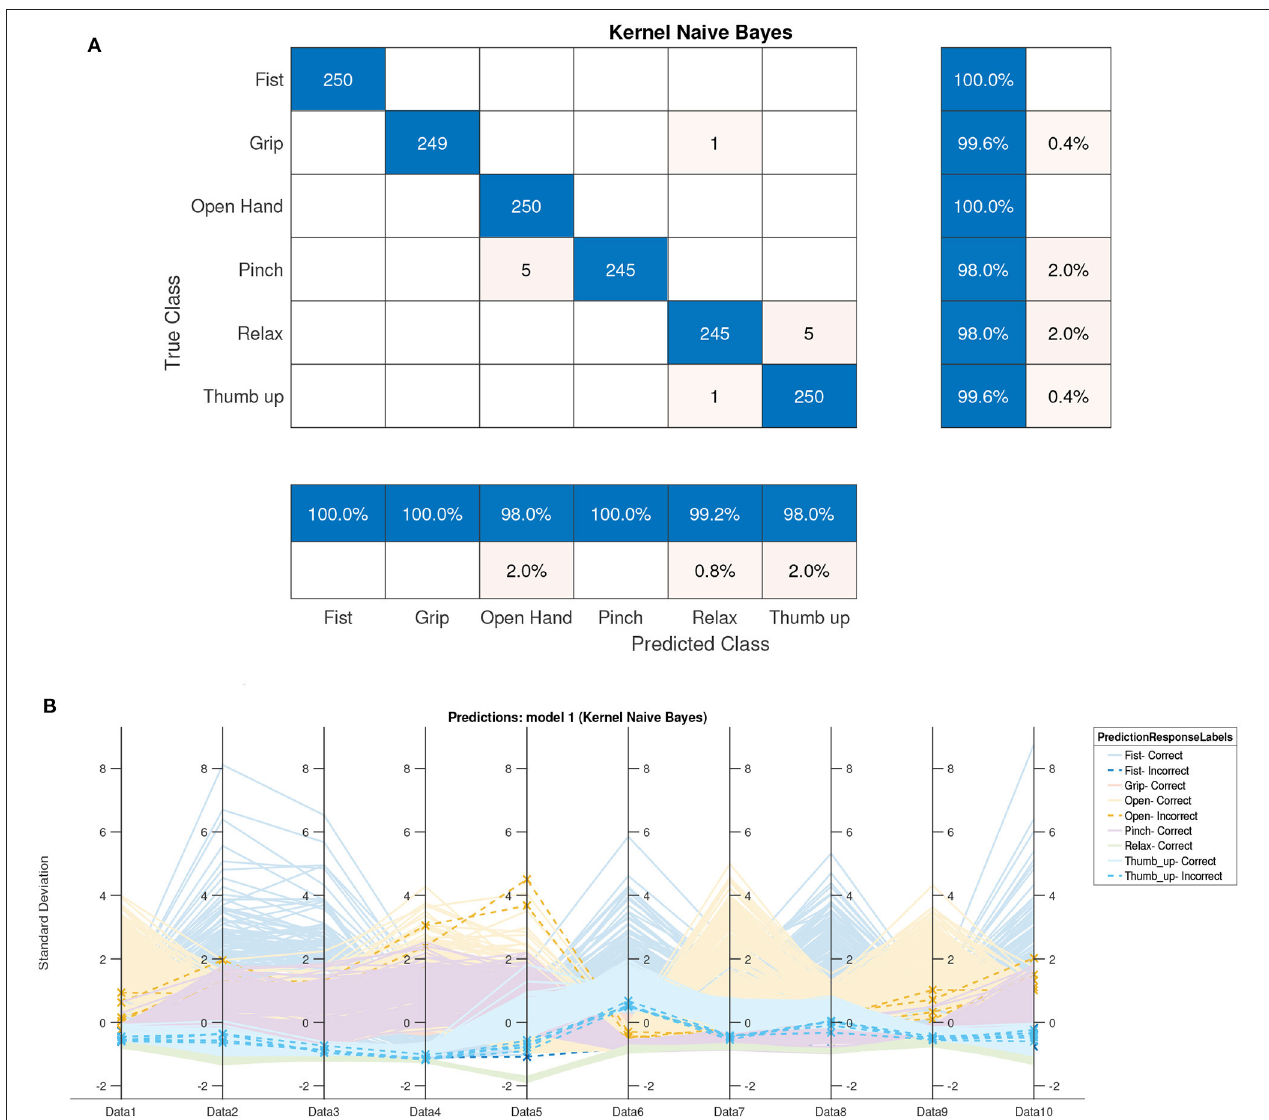
FIGURE 7 | Naive Bayes offline classification results. (A) Confusion matrix of naive Bayes (accuracy 99.2%). (B) Parallel coordinate prediction of naive Bayes.